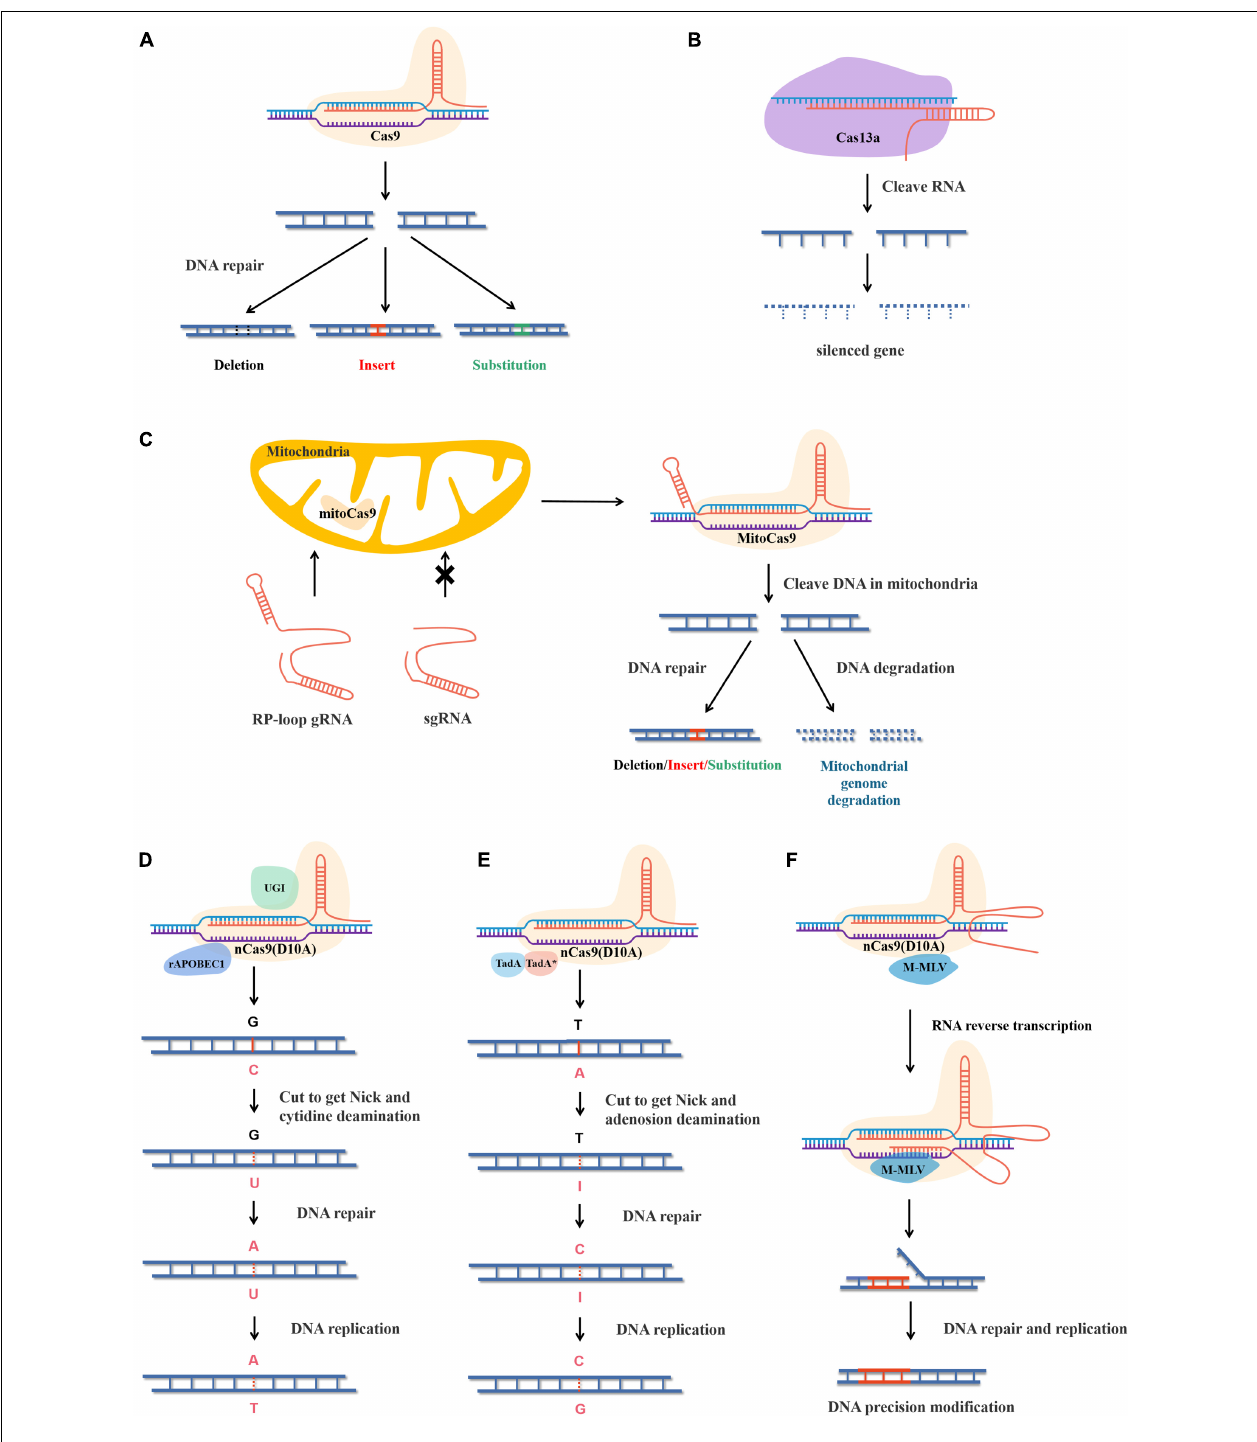
FIGURE 1 | Structure and principle of different gene editing systems. (A) CRISPR-Cas9 cleave double-stranded DNA and causes DSB and the genes are edited under the action of the plant’s own DNA repair mechanism. (B) Rp-loop structure promotes sgRNA entering the mitochondrial and CRISPR-MitoCas9 result mitochondrial gene editing or genome degradation. (C) CRISPR-Cas13a cleaves ssRNA and causes ssRNA degradation. (D) The CBEs replaces bases with cytosine deaminase and T-A replace C-G under the action of plant DNA repair. rAPOBEC1, rat cytidine deaminase; GUI, uracil glycosylase inhibitor. (E) The adenine base editor replaces bases by adenine deaminase and G-C replace A-T under the action of plant DNA repair. TadA, wild-type Escherichia coli tRNA adenosine deaminase. TadA*, mutant TadA. (F) nCas9(D10A) cleaves single strands of DNA to form Nick, and pegRNA acts as a template to replace the sequence under the action of reverse transcriptase. Precise modification of target sequences by plant DNA repair. M-MLV, Moloney mouse leukemia virus reverse transcriptase.